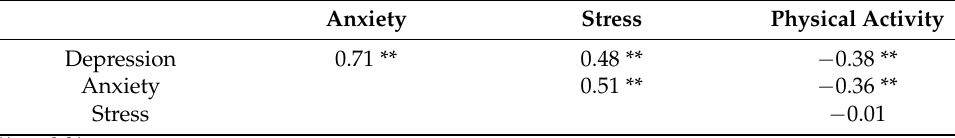
Table 4. Correlation between PA and NMs of college students ( n = 3711).